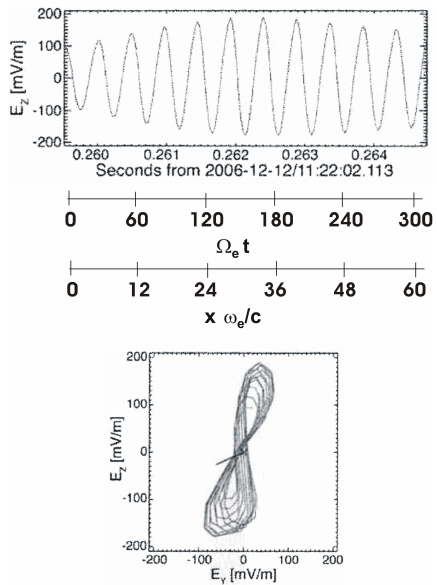
Fig. 10. Measured waveform (top) and hodogram (bottom) of the maximum component versus the intermediate component for the time interval above (adapted from Cattell et al., 2008). The first additional scale is obtained by multiplying the time (from zero to 0 . 005s) with the electron cyclotron frequency of (cid:127) e = 6 × 10 4 s − 1 according to a magnetic field of B o ∼ 320nT. The second spatial scale, in units of the electron skin depth c/ω e , follows directly from the upper one by multiplying it with a normalized phase velocity of V ph /V Ae = 0 . 2 and allows a direct comparison with the oscilliton waveform plotted in Figs. 8 and